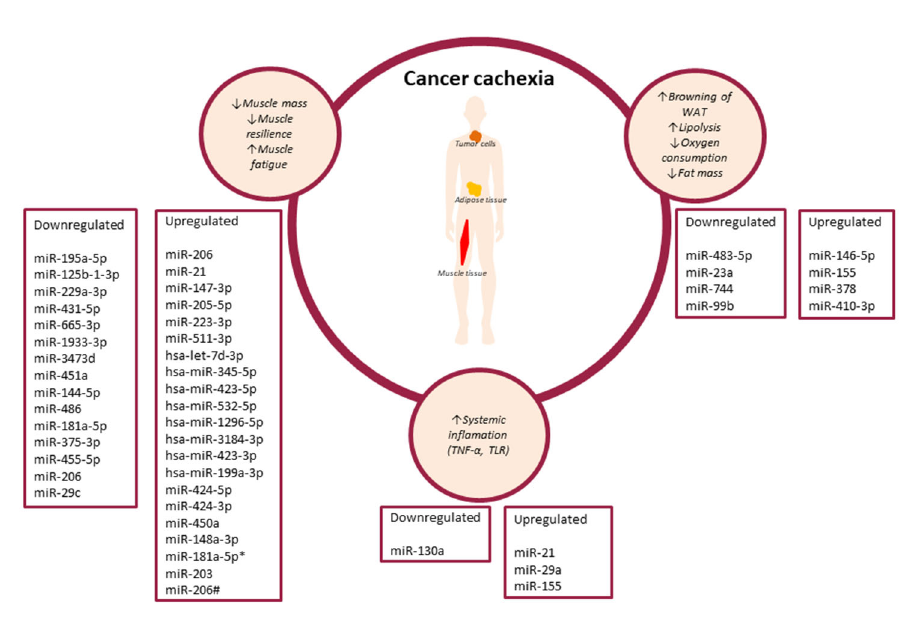
Figure 1. The influence of selected miRNAs on the immune system, adipose tissue and muscle tissue in the context of the development of cancer cachexia. ( ↓— decrease, ↑— increase).